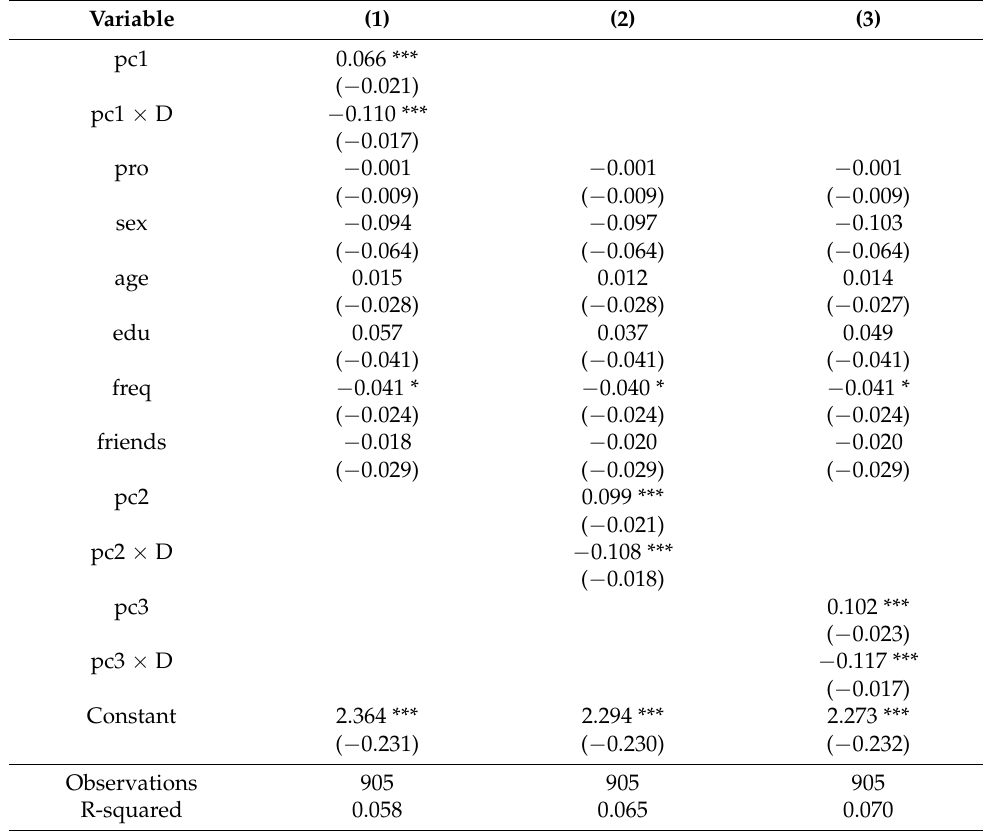
Table 6. The results of